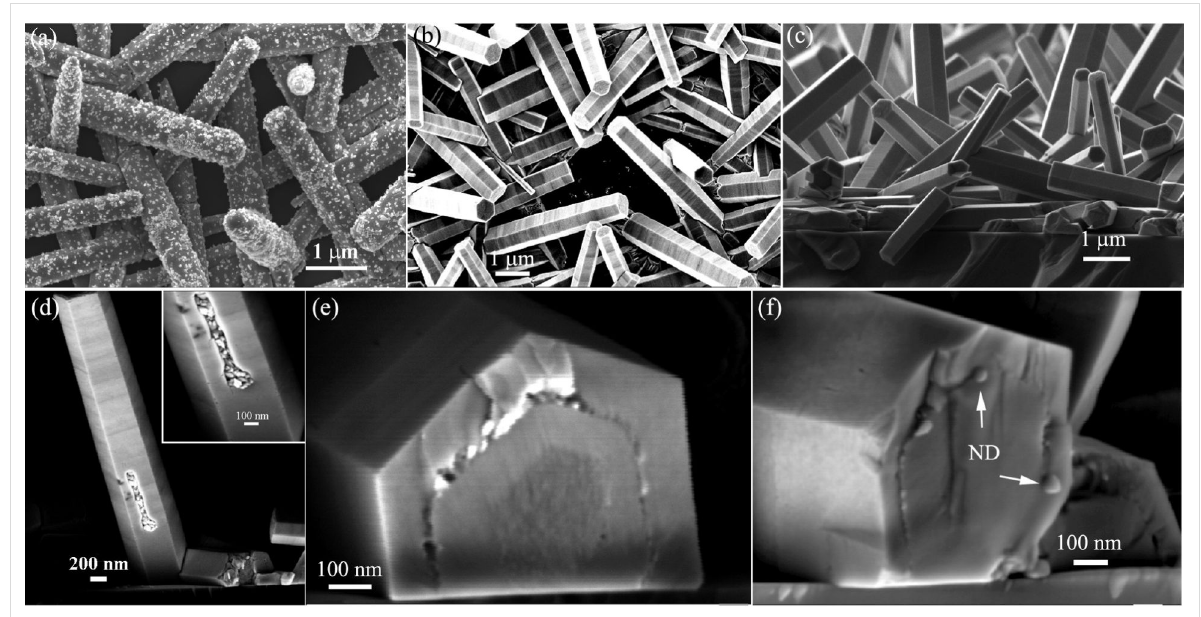
Figure 2: FE-SEM images showing the encapsulation of 40-nm-diameter NDs into ZnO nanorods. (a) ZnO nanorods covered with NDs. (b and c) Top- and side-view images of the nanorods after a second growth process, showing the complete encapsulation of NDs into the nanorods.